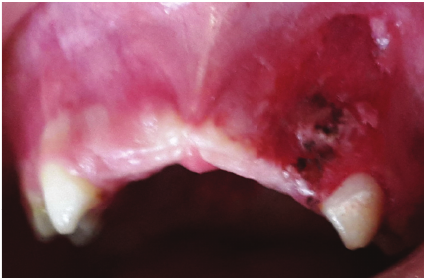
Figure 1: Intraoral preoperative view of lesion: a painless red enlargementofthemaxillaryattachedgingivaextendstothealveolar mucosa between teeth #52 and 53.